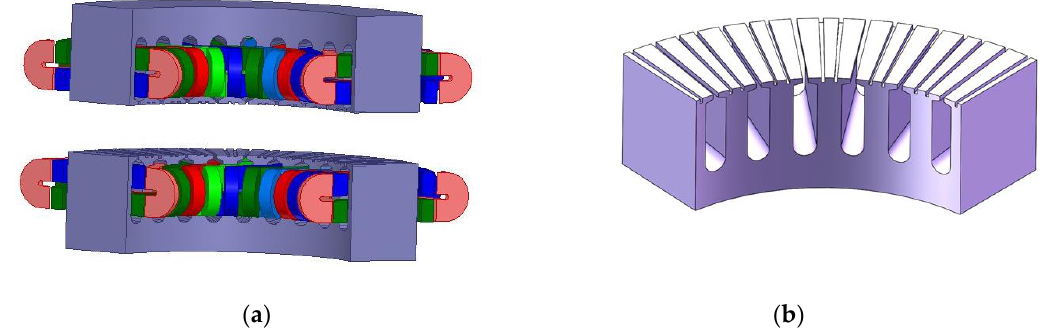
Figure 8. AFPMSM auxiliary slot schematic. ( a ) Finite element analysis model. ( b ) Partial enlarged view of the auxiliary slot.